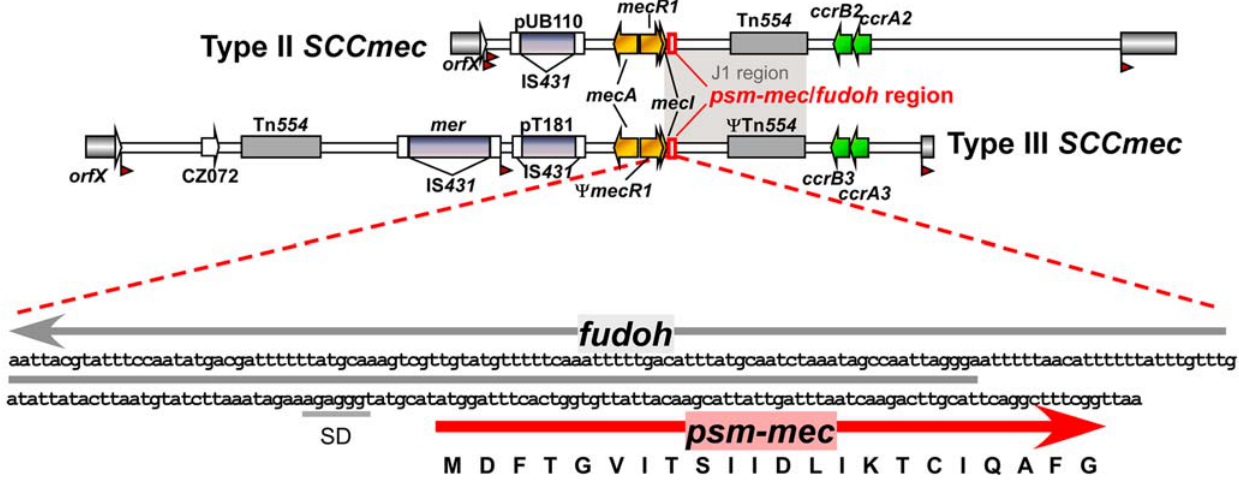
Figure 3. Location of the psm-mec gene in SCC mec elements of types II and III. Type II and III SCC mec elements are shown on the top, based on Genbank accession numbers D86934 (strain S. aureus N315, type II) and AB037671 (type III) [14]. The essential mec (methicillin resistance and regulation) and ccr (recombinase) genes are shown in color, other accessory elements are in grey. The region that contains the psm-mec gene and the overlapping fudoh locus [39] is magnified at the bottom. SD, Shine-Dalgarno